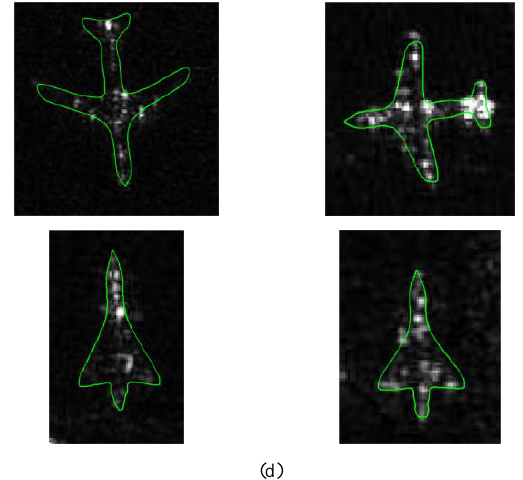
Figure 4. The experiment of comparison. (a) Original SAR chips. (b) LGIF. (c) RSF (d) The proposed